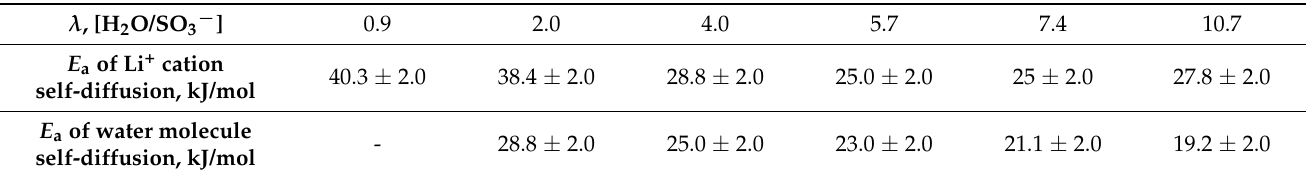
Table 8. Activation energies of Li + and water molecule self-diffusion in the Li + ionic form of the Nafion membrane E a at different water contents λ . Reprinted with permission from Ref. [60]. Copyright © 2022 Elsevier B.V. All rights reserved.